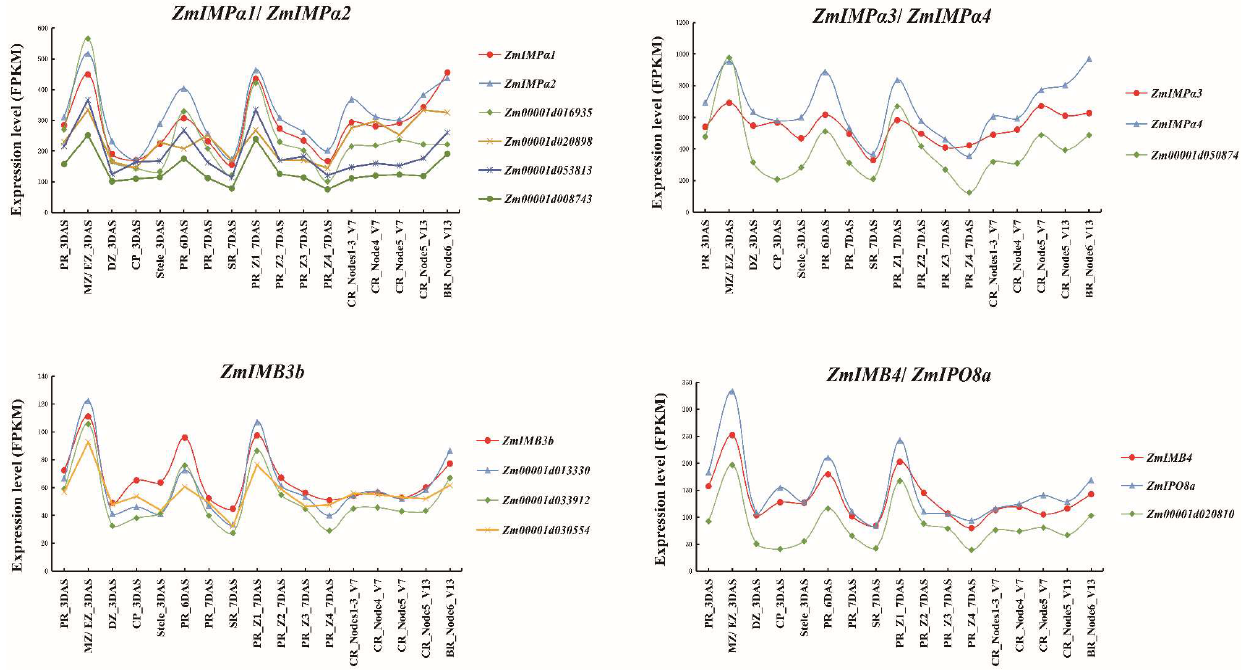
Figure 5. Gene expression profiles of ZmKAPs and interacting partners in the root. PR: Primary Root, MZ: Meristem Zone, EZ: Elongation Zone, DZ, Differentiation Zone, CP: Cortical Parenchyma, SR: Seminal Roots, Z1: Zone 1(root tips region), Zone 2 (from the end of Z1 to the point of root hair or lateral root initiation), Zone 3 (lower half of differentiation zone); Zone 4 (upper half of differentia- tion zone), CR: Crown Roots, BR: Brace Roots, DAS: Day After Sowing, V: Vegetative.